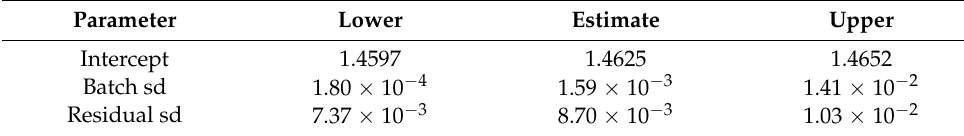
Table 3. Model parameter (Equation (7)) for process capability